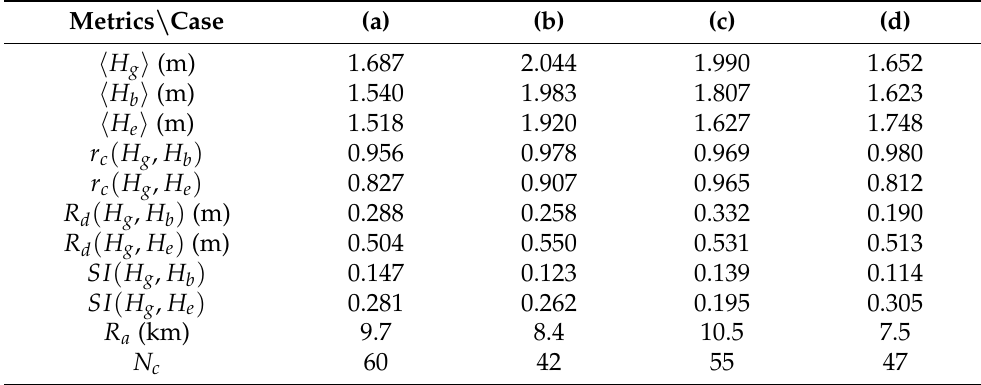
Table 3. Comparisons of GPS wave heights and ERA5 wave heights for various cases in Figure 2c. (a) Case of winds from the sea, which means u w > 0 for the buoy C, u w < 0 buoys for D, E, F, G, and H, and v w > 0 for buoys J, K, P, and Q (Figure 1), where ( u w , v w ) are ERA5 wind vectors at the JMA drifting buoy positions. (b) Case except (a). (c) Buoys C, D, E, F, G, and H. (d) Buoys J, K, P, and